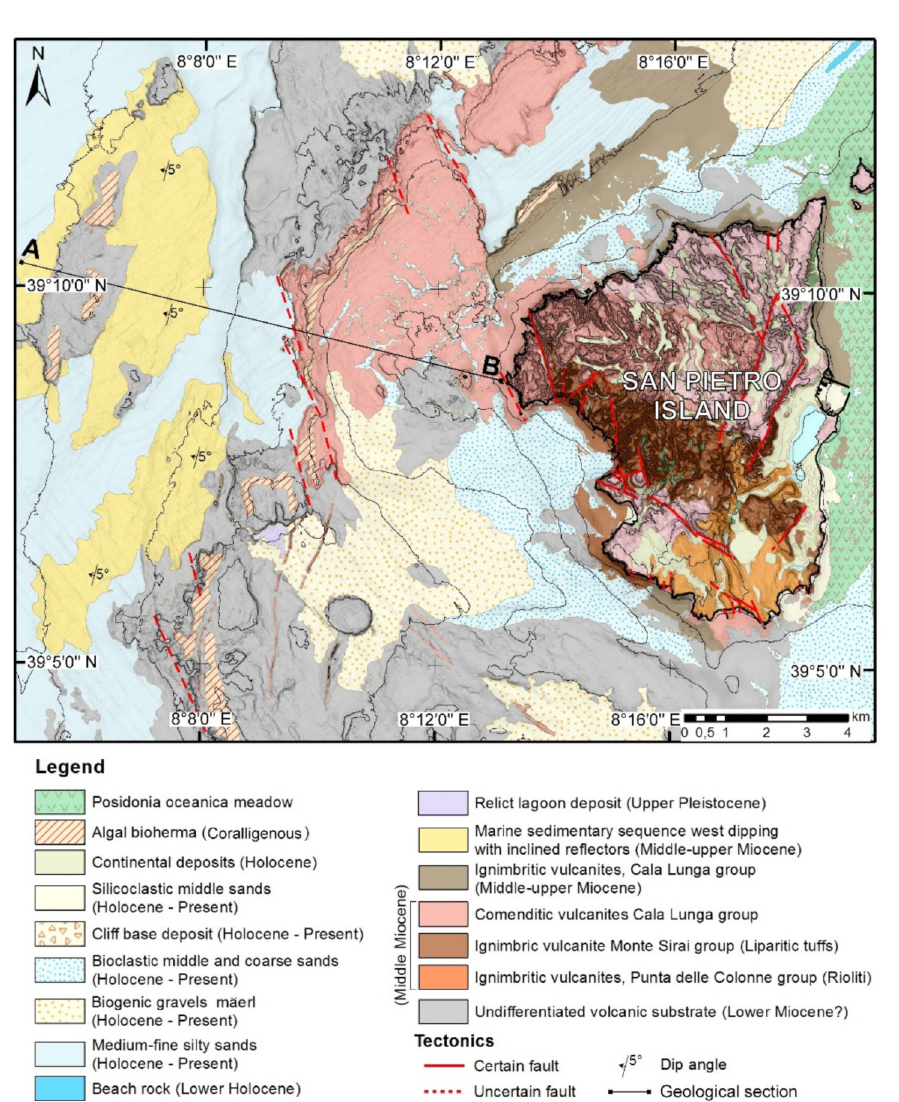
Figure 3. Geolithological sketch map of study area from the Geological Map of Italy. Scale 1:50,000—Sheet 563 “Isola di San Pietro” (Rizzo et al., 2015 [35]).